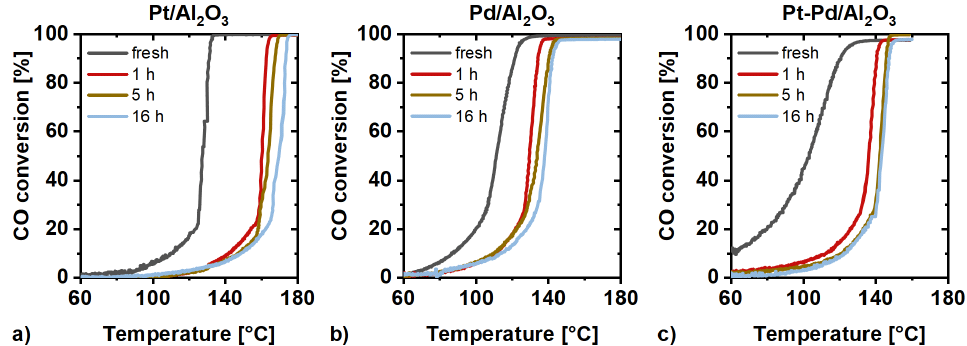
7 of 18 Figure 4. Energy dispersive X-ray spectroscopy (EDXS) scan of Pt-Pd particles in the fresh state ( a ) and after aging for 1 h at 750 °C ( b ), 5 h at 750 °C ( c ) and 16 h at 750 °C ( d ). Figure 5. Representative EDXS line scan of a single Pt-Pd particle after aging for 16 h at 750 °C with an overview on the elemental composition of the bimetallic particle ( a ) and the detailed ele- mental concentrations along the line scan ( b ). 2.3. Catalytic Activity Measurements Light-off measurements after an either reductive or oxidative pretreatment were con- ducted in order to evaluate the catalytic activity at several aging states. For this, the cata- lyst was heated with a ramp rate of 3 K/min from 60 °C to 180 °C in a gas mixture of 800 ppm CO, 7% CO 2 , 5% O 2 , 5% H 2 O and balance N 2 (GHSV = 80 000 h − 1 ) while monitor- ing the CO conversion. Figure 6 summarizes the CO light-off activity of all catalyst sam- ples after reduction prior to the activity test. In the fresh catalyst state we observed the highest CO oxidation activity for prereduced Pt-Pd/Al 2 O 3 , exhibiting a T 50 (temperature of 50% conversion) of 103 °C, whereas T 50 was 111 °C for Pd/Al 2 O 3 and 127 °C for Pt/Al 2 O 3 . Irrespective of the catalyst formulation, the first hour of hydrothermal aging caused the most pronounced deactivation (Figure 6) for all samples, resulting in a T 50 of 162 °C for Pt/Al 2 O 3 , 129 °C for Pd/Al 2 O 3 , and 136 °C for Pt-Pd/Al 2 O 3 . Hence, the bimetallic Pt- Pd/Al 2 O 3 catalyst benefits from Pd addition as it shows less deactivation after one hour of aging than the monometallic Pt/Al 2 O 3 sample. This trend is also valid after 5 h and 16 h of aging, respectively, ultimately resulting in a T 50 of 170 °C for Pt/Al 2 O 3 and 143 °C for Pt- Pd/Al 2 O 3 . With an aging-induced shift of T 50 by 27 °C towards higher temperatures, mon-